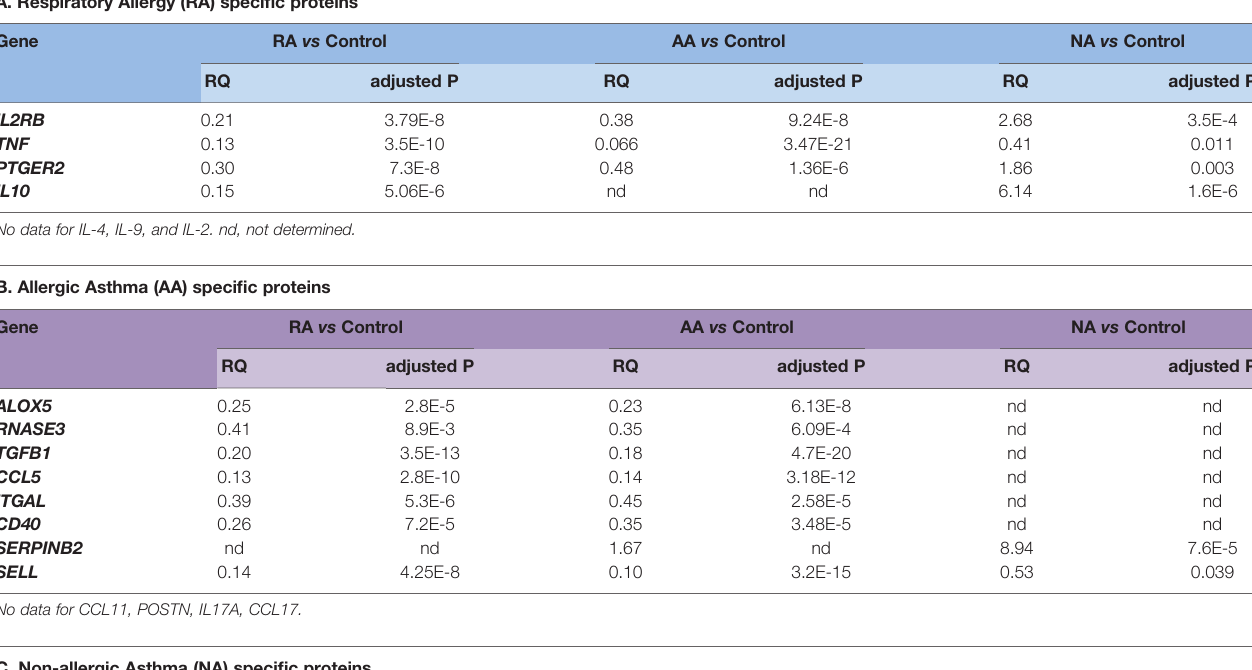
TABLE 6 | Relative Quanti fi cation (RQ) values of gene expression in speci fi c proteins de fi ned by systems biology.